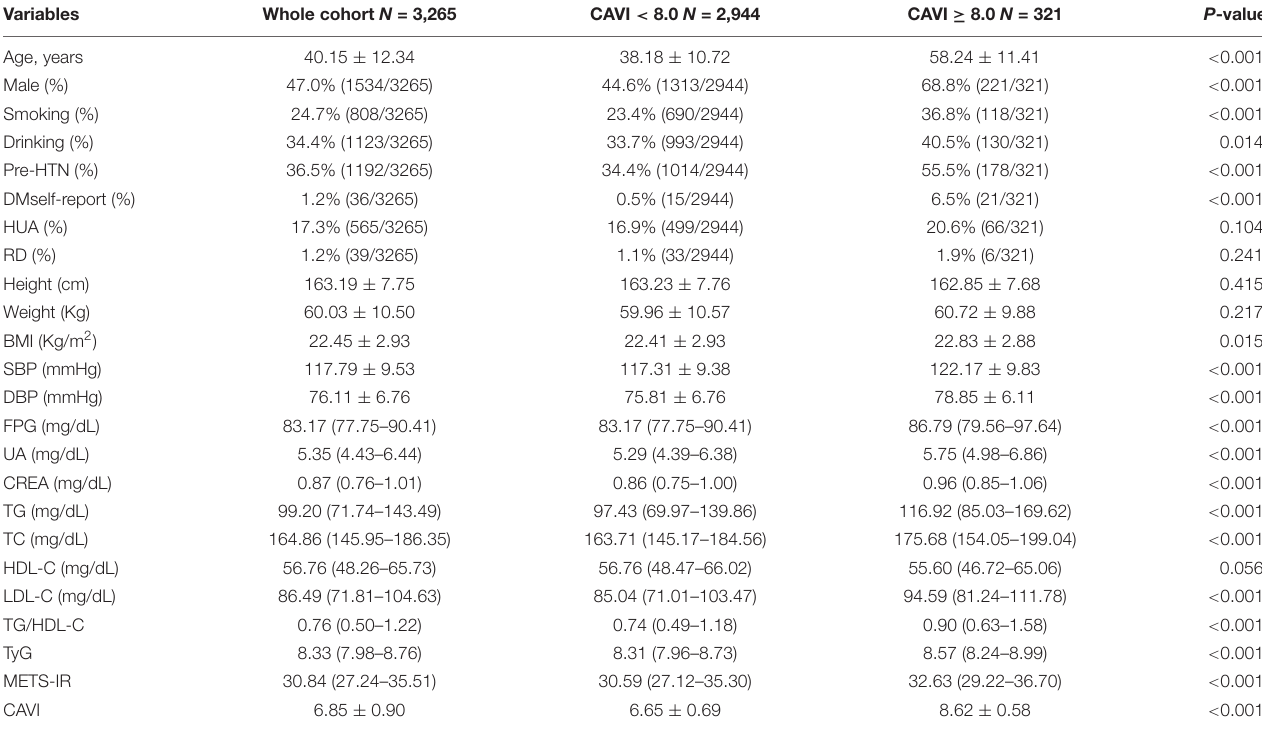
TABLE 1 | Baseline characteristics of the individuals included in the analysis. Variables